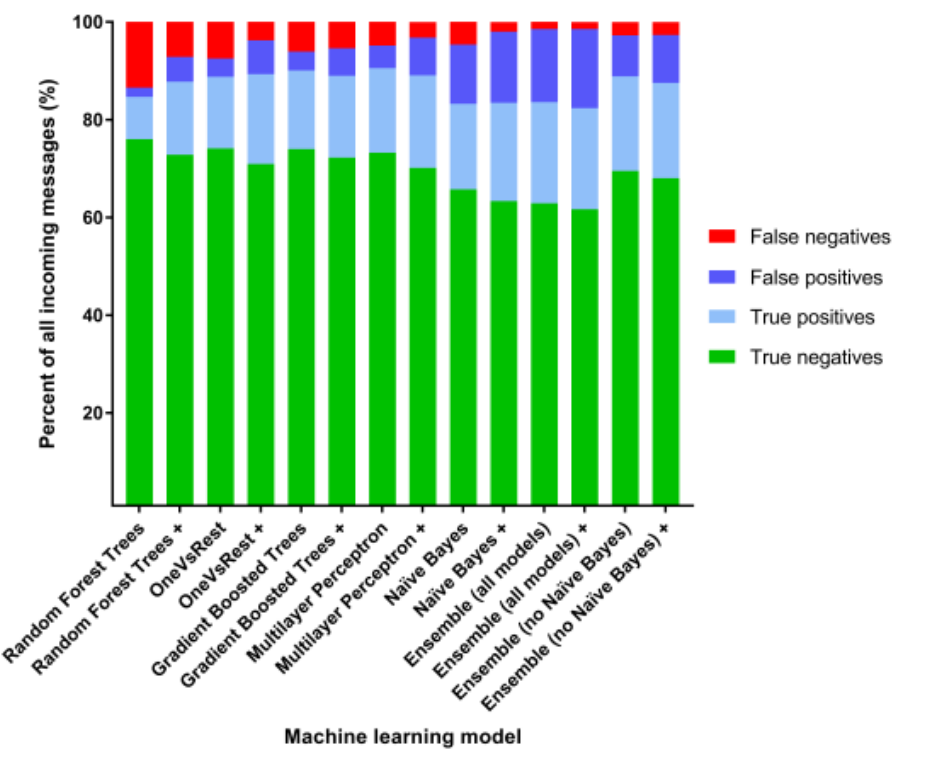
Figure 2. Machine learning model performance. +: model with heuristics added.